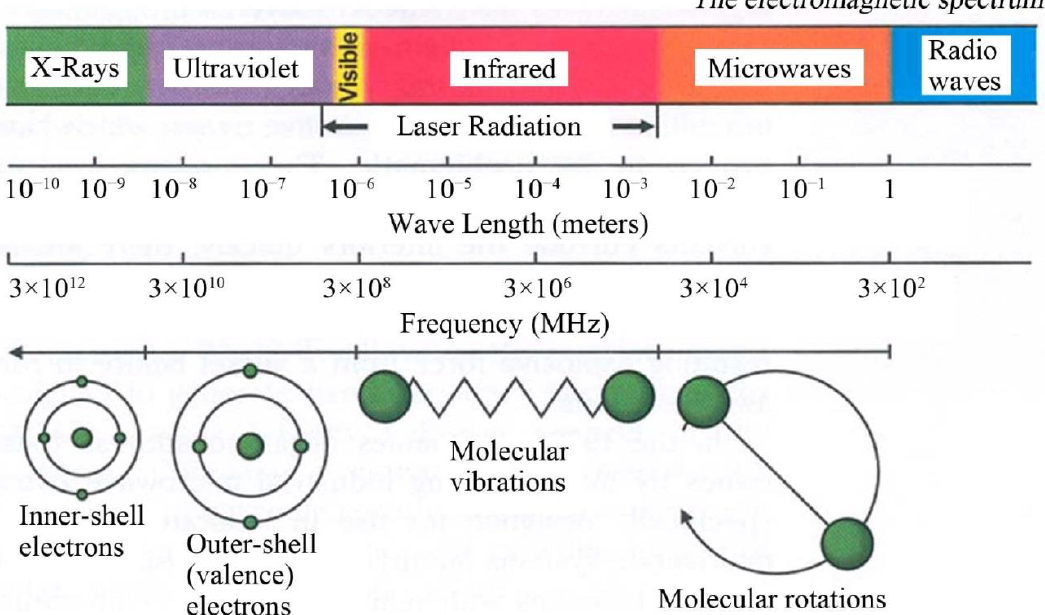
Figure 7. The electromagnetic spectrum showing characteristics of microwaves. Reprinted with